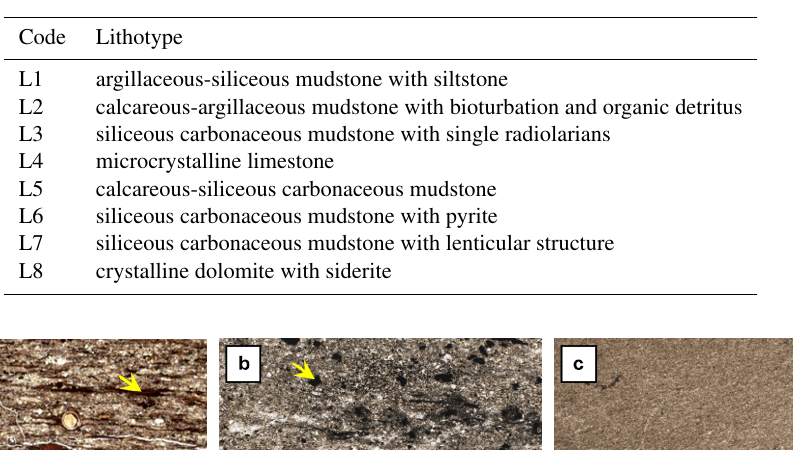
Table 1. Lithotypes of the target collection.